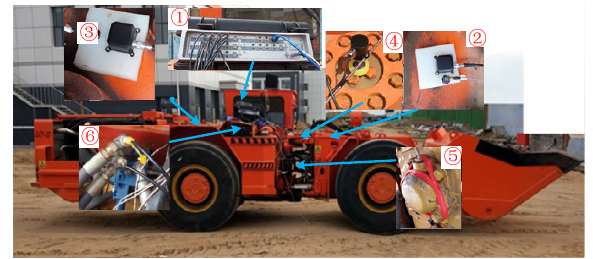
Figure 6. Field test system of target